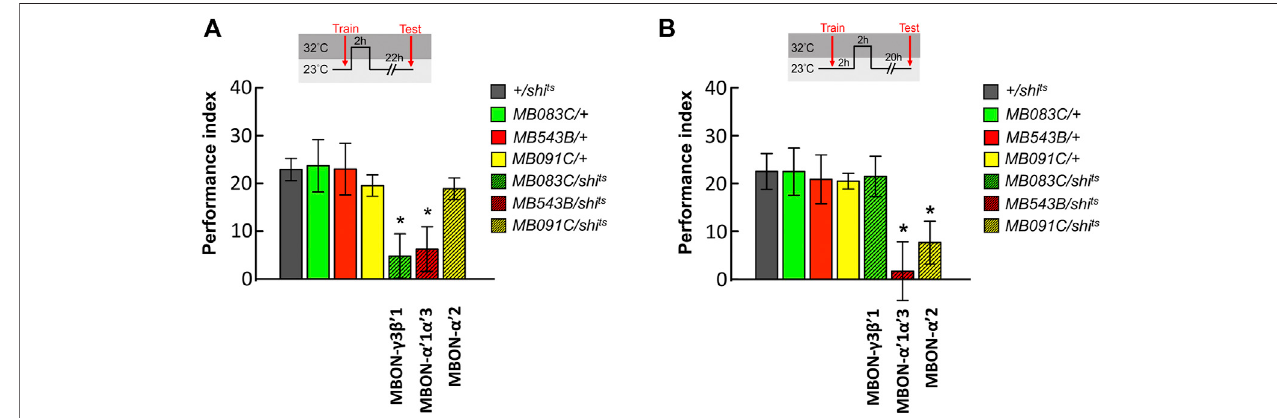
FIGURE 3 | Sequential utilization of α ′ β ′ -MBONs for sustaining wLTM consolidation. (A) Blocking neurotransmission in MBON- γ 3 β ′ 1 or MBON- α ′ 1 α ′ 3 via shi ts at 0 – 2 hperiodaftertrainingdisruptedwLTM.Eachvaluerepresentsmean ± SEM(N (cid:1) 14,10,8,9,10,8,and9fromlefttorightbars).* p < 0.05;one-wayANOVAfollowed by Tukey ’ s test. (B) Blocking neurotransmission in MBON- α ′ 1 α ′ 3 or MBON- α ′ 2 via shi ts at 2 – 4 h period after training disrupted wLTM. Each value represents mean ± SEM (N (cid:1) 13, 12, 9, 8, 12, 9, and 11 from left to right bars). * p < 0.05; one-way ANOVA followed by Tukey ’ s test.